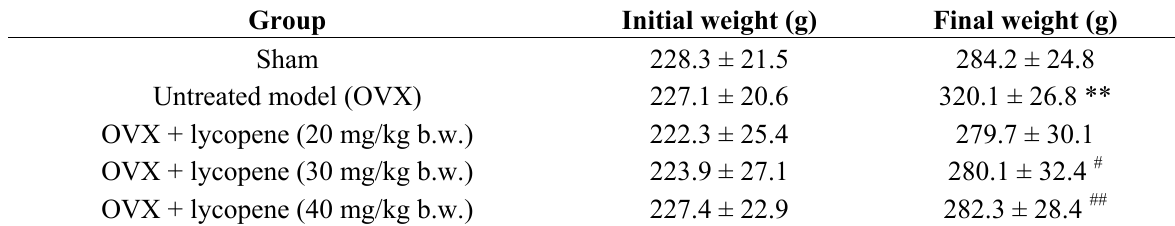
Table 1. Effect of lycopene on initial and final body weight in experimental